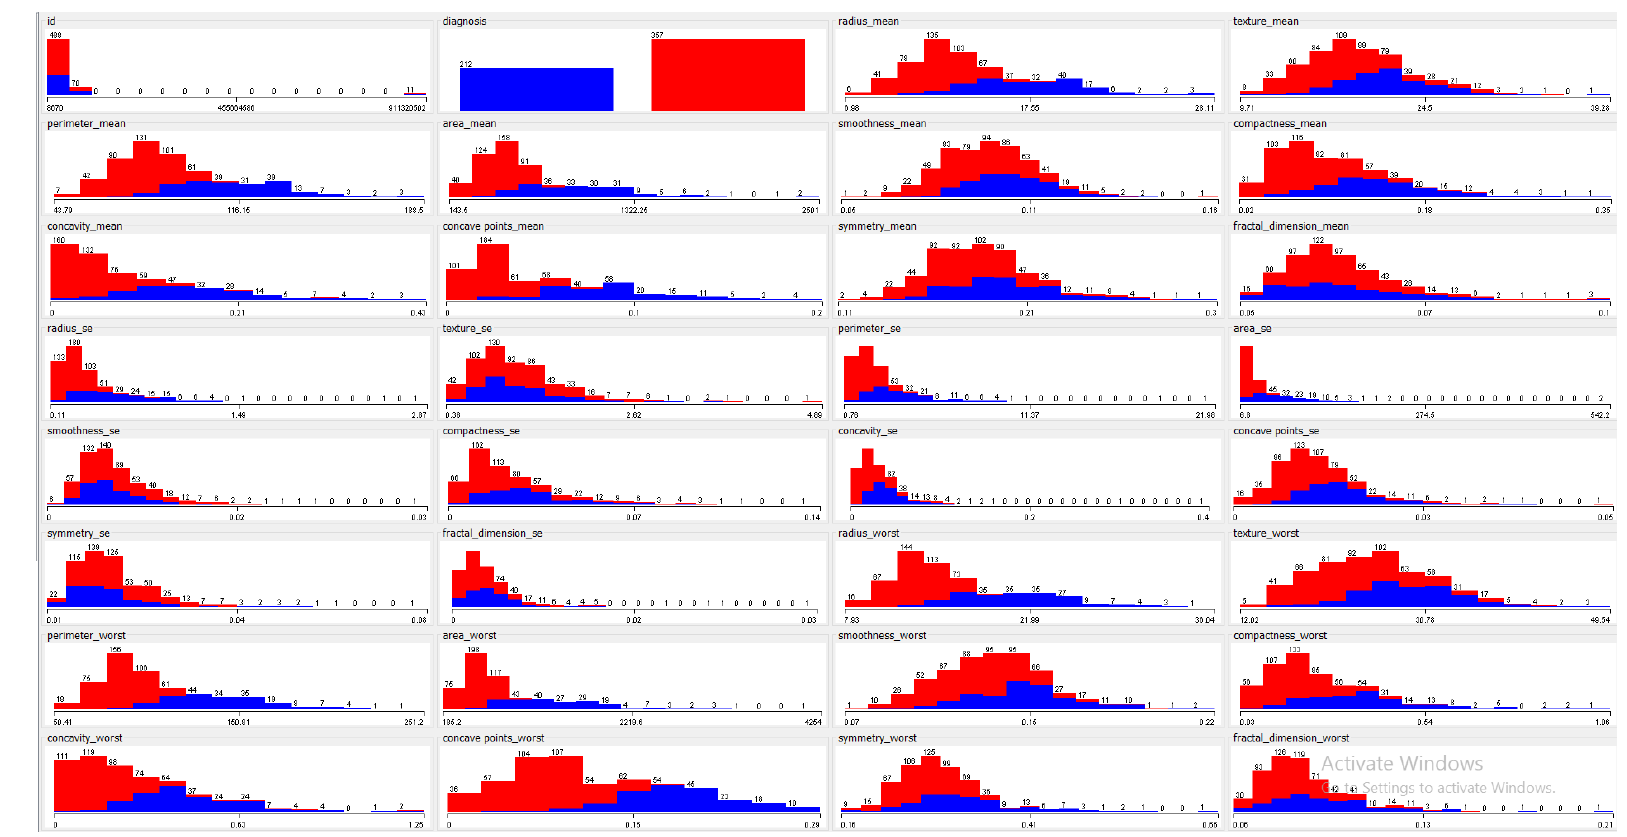
Figure 2. Feature visualization result for WBCD (x-axis represents the attribute value and y-axis represents the frequency of each